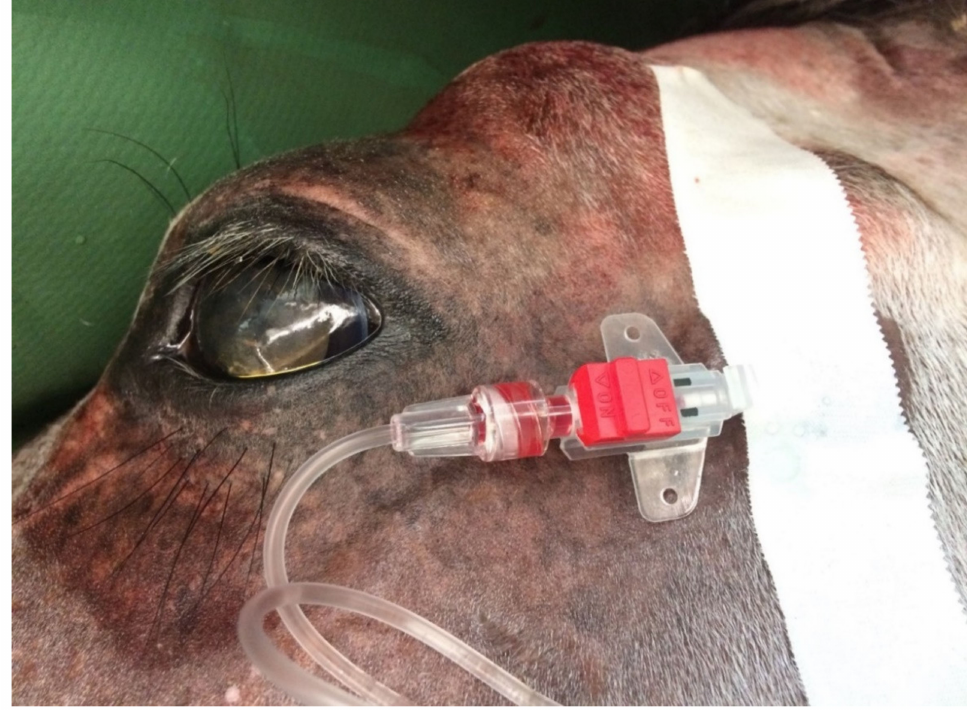
Figure 4. Special arterial catheter placed in the transversal facial artery, which allows one to take samples of arterial blood during a surgical